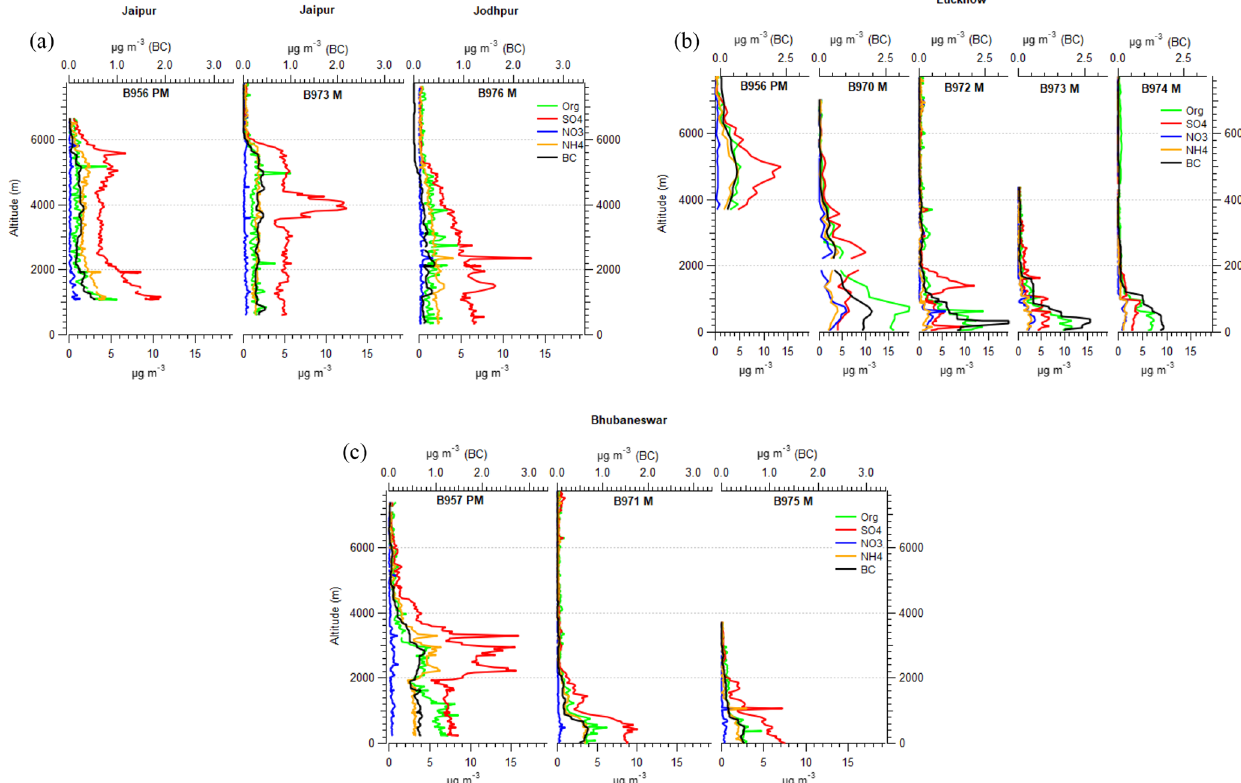
Figure 11. Vertical profile aerosol chemical composition for (a) Jaipur/Jodhpur in NW India, (b) Lucknow in the IGP, and (c) Bhubaneswar in NE India. Data presented here are for the pre-monsoon (PM) and monsoon (M) season. The figures show AMS (bottom x axis) and SP2 (BC) (top x